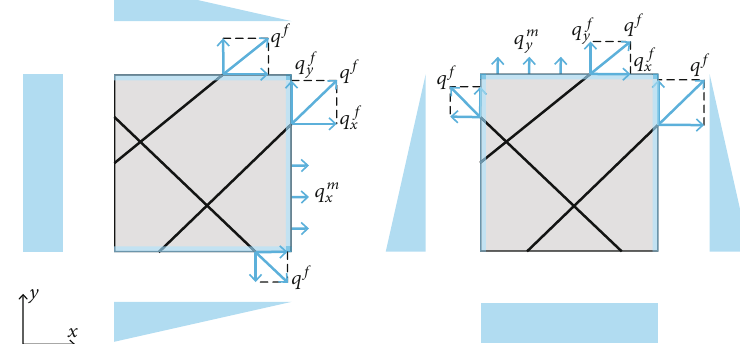
Figure 3: Calculating fl ow rates on multiple boundaries for a grid block under linear boundary conditions along the x -axis (left) and y -axis (right).